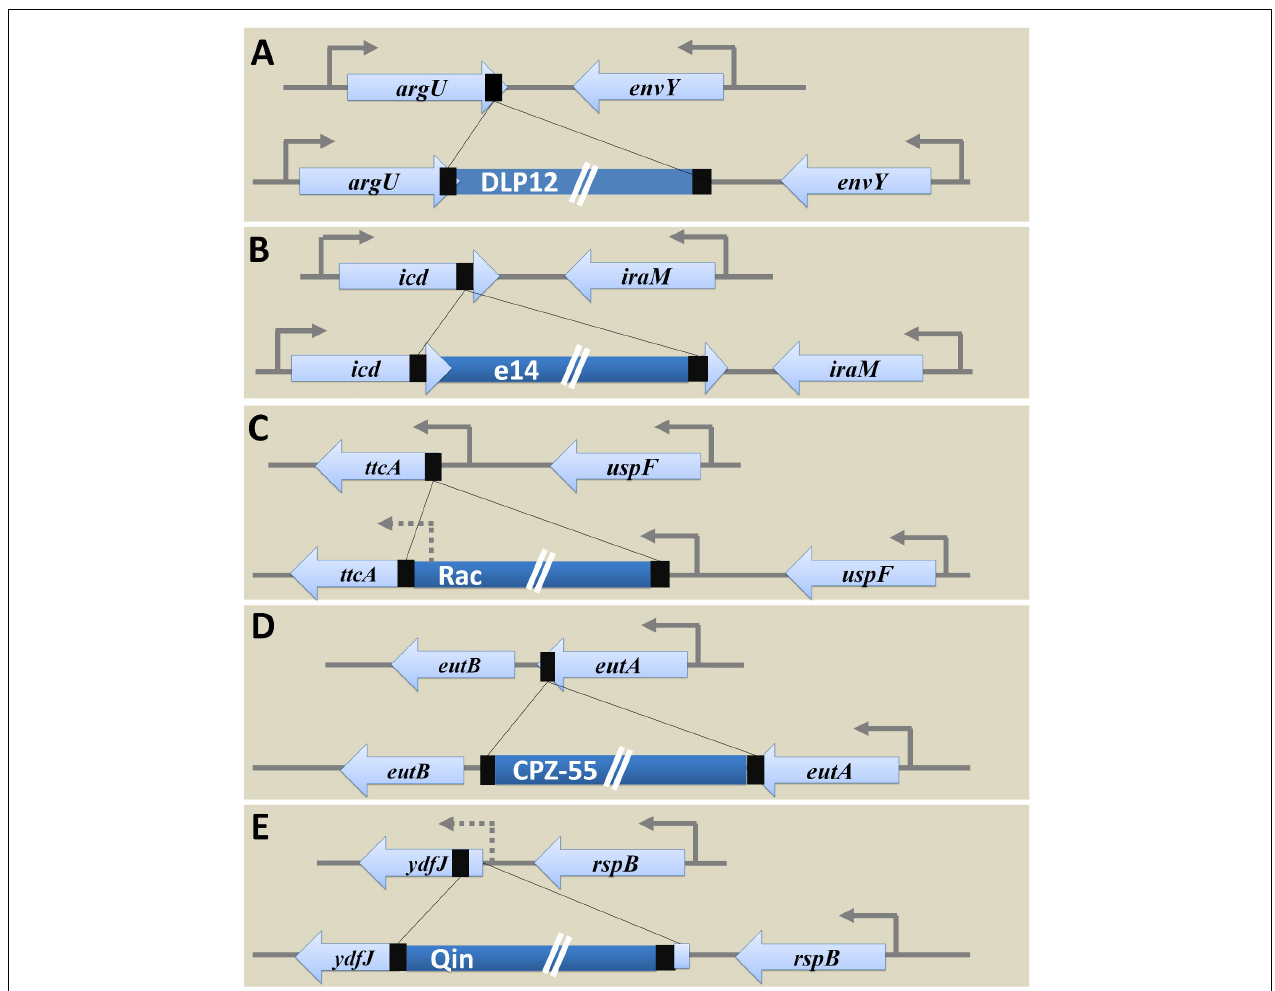
FIGURE 4 | Genetic variations caused by prophage integration in E. coli MG1655. The examination of specific integration loci of each of the five prophages (DLP12, e14, Rac, CPZ-55, and Qin) concerning E. coli MG1655 among the strains with and without corresponding prophages uncovered the genetic variations caused post integration event as shown above. (A) Integration of DLP12 via homologous recombination near the 3 (cid:48) end of the argU gene. The 47 bp region similar to 3 (cid:48) end of argU gene is located on the other end of the DLP12. (B) Integration of e14 at the 3 (cid:48) end of icd gene causing the formation of pseudo icd’ (163 bp) gene as a duplicated region. (C) Site-specific integration of Rac at the 5 (cid:48) end of ttcA gene. The variation in the N-terminus of TtcA protein was observed. (D) The transposon-like integration of CPZ-55 next to the stop codon of the eutA gene causing duplication of 8 bp region. No variations were seen in the bacterial flanking genes ( eutB and eutA ). (E) The site-specific integration of Qin at the 5 (cid:48) end of ydfJ gene resulting in promoter loss and truncation (lacking 28 codons at the N terminal) of YdfJ